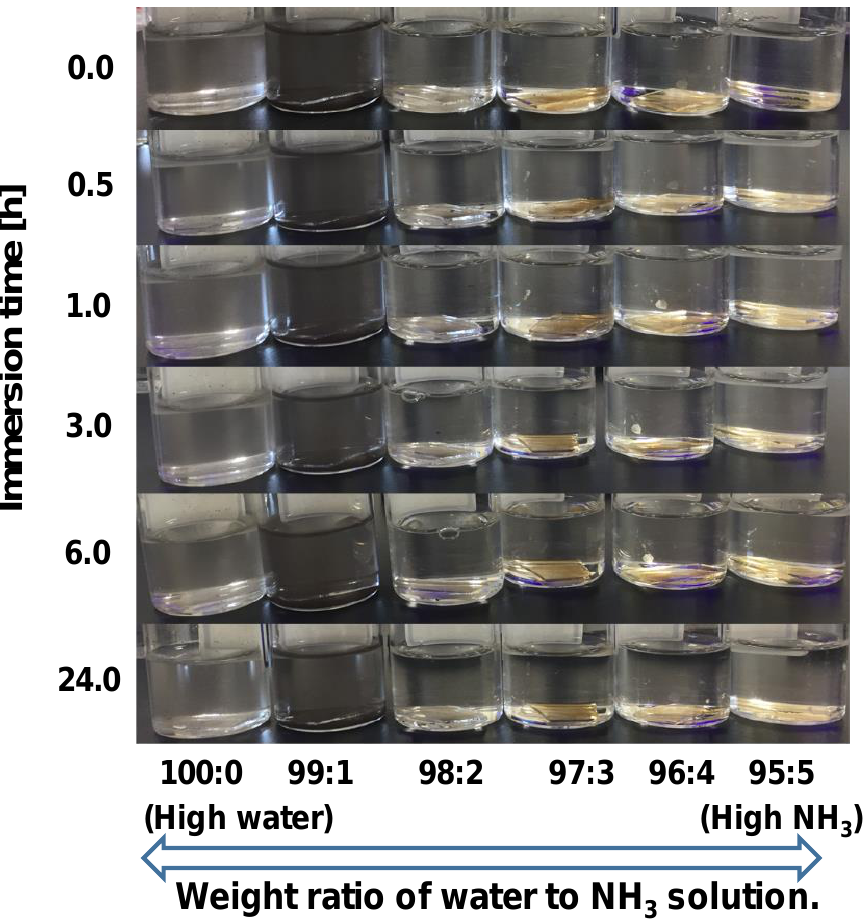
Figure 9. Ag + reduction reaction in the presence of NH 3 in solution .